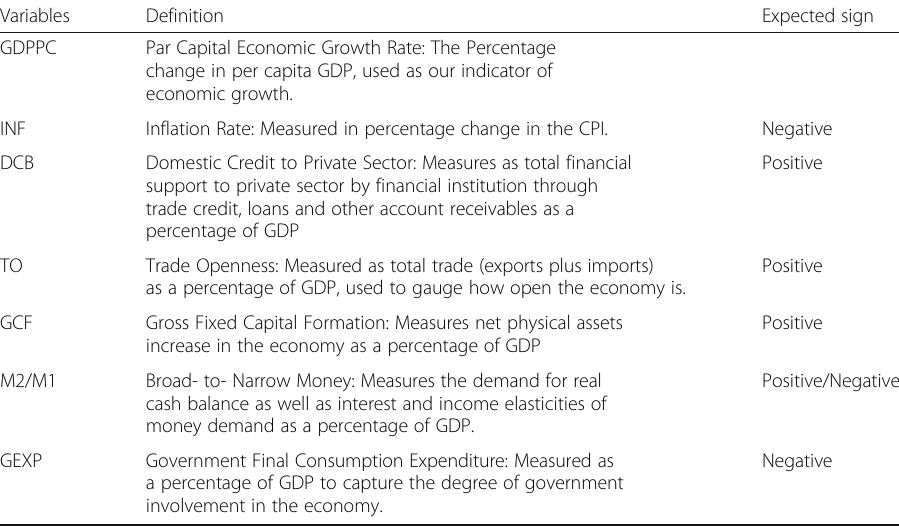
Table 1 Variable Definitions with Their Expected Signs Variables